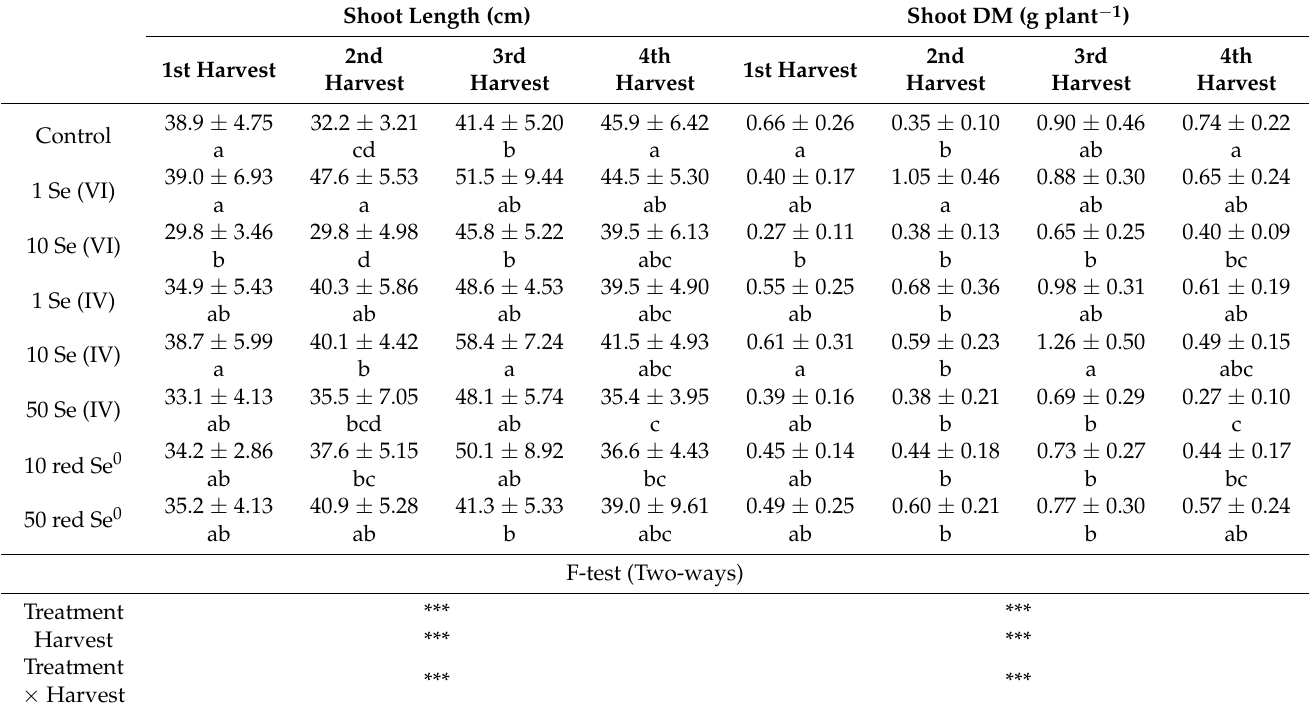
Data presented are mean ± SD ( n = 9). Means in the same column and within the same year followed by different letters are significant according to Tukey’s test ( p ≤ 0.05). *** significant according to Tukey’s test ( p ≤